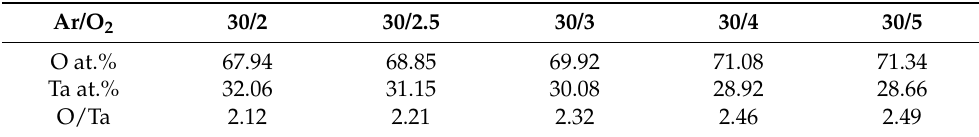
Figure 5. The XPS spectra of ( a ) Ta 4f and ( b ) O1 s for the TaO x thin films sputtered with various Ar/O 2 ratio. Table 2. Summary of the XPS results for TaO x film deposited by various Ar/O 2 ratio.